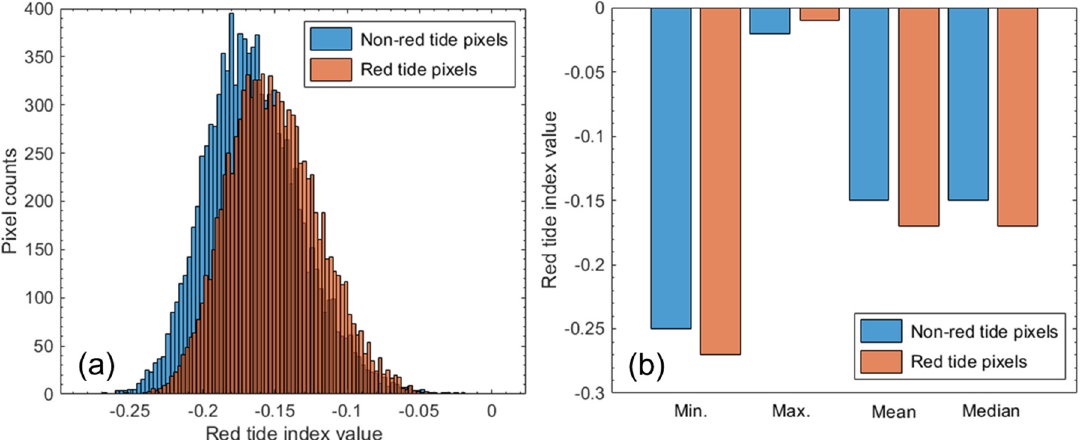
Figure 6. ( a ) Histograms of red tide index (RTI) values in relation to 10,000 non-red tide pixels and 10,000 red tide pixels in a PlanetScope image acquired on 29 July 2018 01:42 GMT near the coast of Goheung. ( b ) The statistics calculated from RTI distribution of randomly-selected pixels of each group. Min. and Max. are minimum and maximum values, respectively.